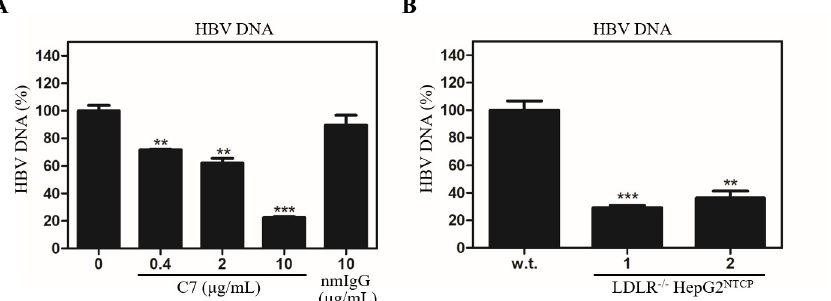
Fig 8. Inhibition of HBV cell attachment by C7 and LDLR gene knockout. HepG2 NTCP cells in 24-well cell culture plates were incubated with HBV in the presence of increasing concentrations (0, 0.4, 2, and 10 μ g/mL) of LDLR- specific monoclonal antibody C7 or 10 μ g/mL nmIgG at 37˚C for 6 h. Unbound HBV was removed by washing cells with 1xPBS three times. Cell-bound HBV DNA was extracted with a QIAGEN DNA isolation kit, followed by real- time PCR quantification ( A ). HBV cell attachment to parental and LDLR -/- HepG2 NTCP cells were compared after incubation with HBV at 37˚C for 6 h. Upon removal of unbound HBV, HBV DNA in the cell was quantified by a Real- Time PCR method ( B ). Average values calculated from three repeats are shown. �� P < 0.01, ��� P < 0.001.